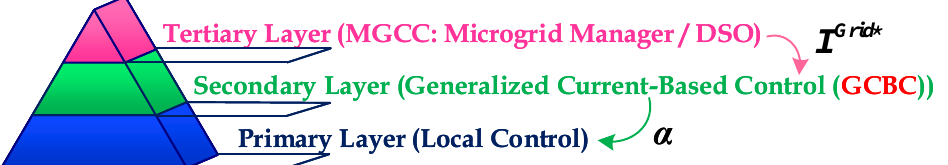
Figure 2. MG hierarchical control architecture with the integration of GCBC